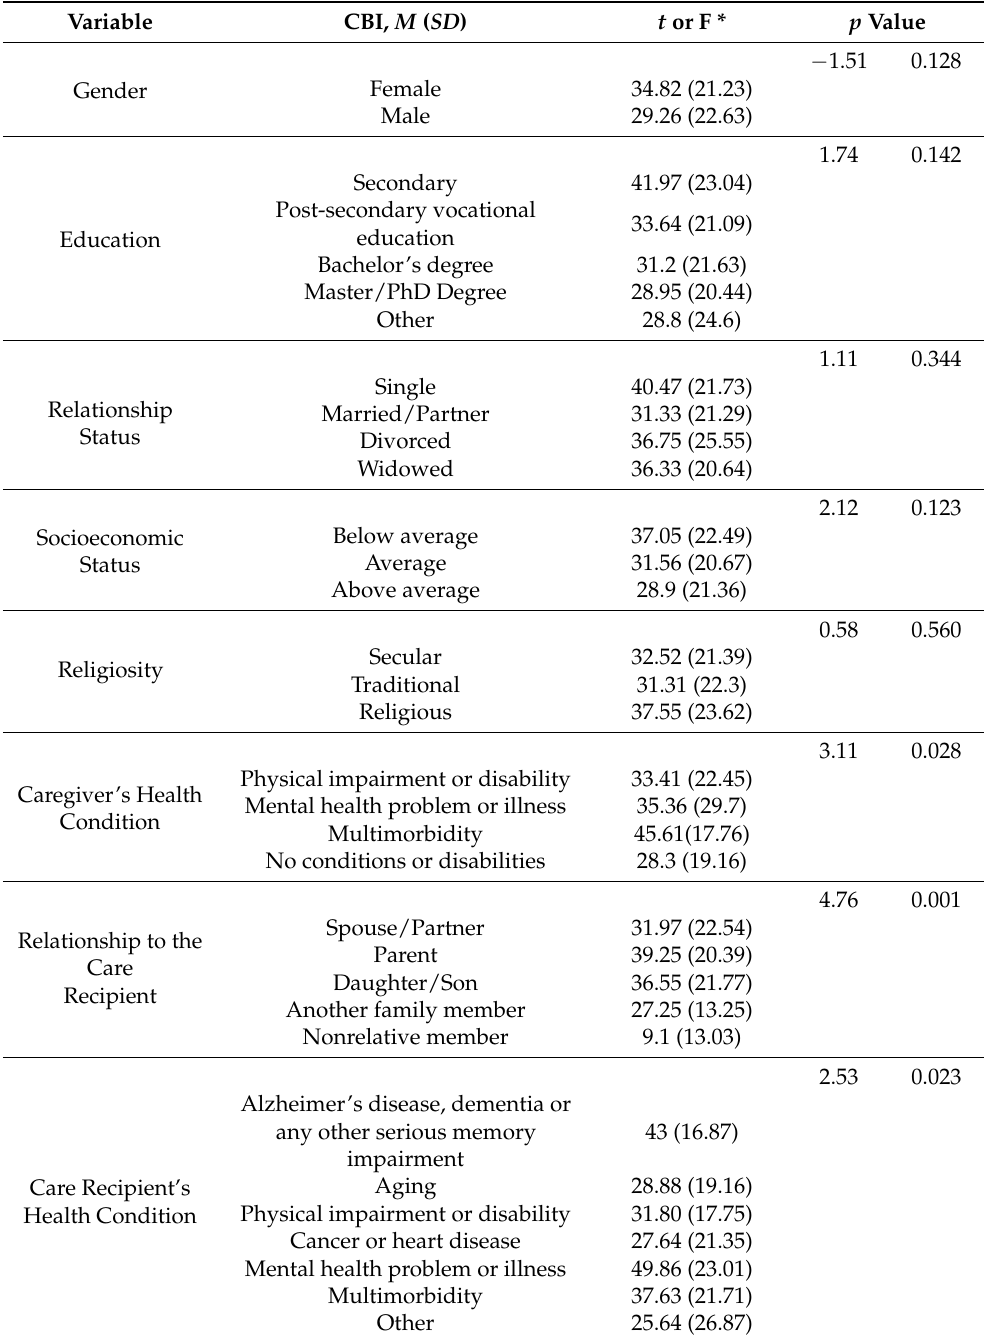
Table 3. Differences in caregiver burden depending on sociodemographic